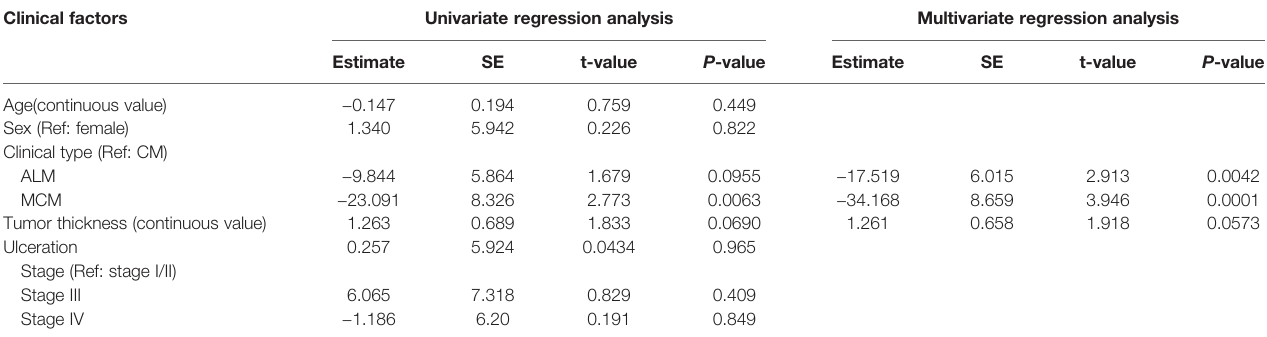
TABLE 2 | Association of total TIL number with clinical factors. Clinical factors